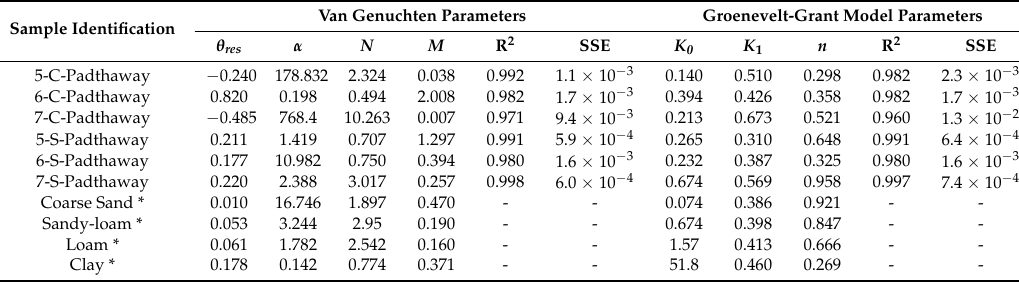
Table 2. Van Genuchten and Groenevelt-Grant soil water retention model parameters for grapevine biochar